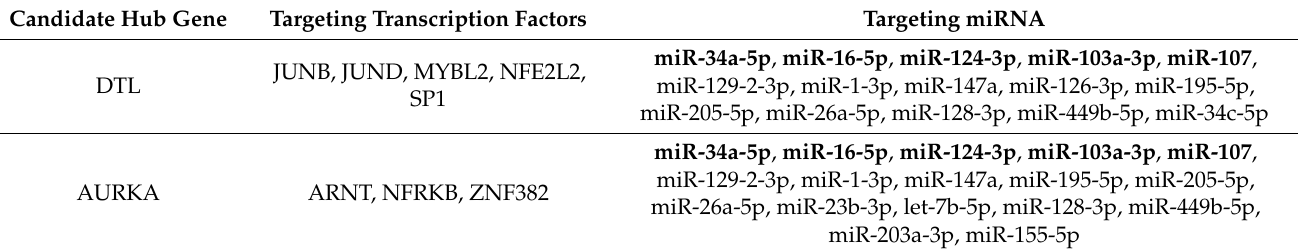
The top five targeting miRNA for each candidate hub gene are marked in bold font. GINS2 and TTK had no common transcription factor between the two databases—TTRUST and ENCODE.